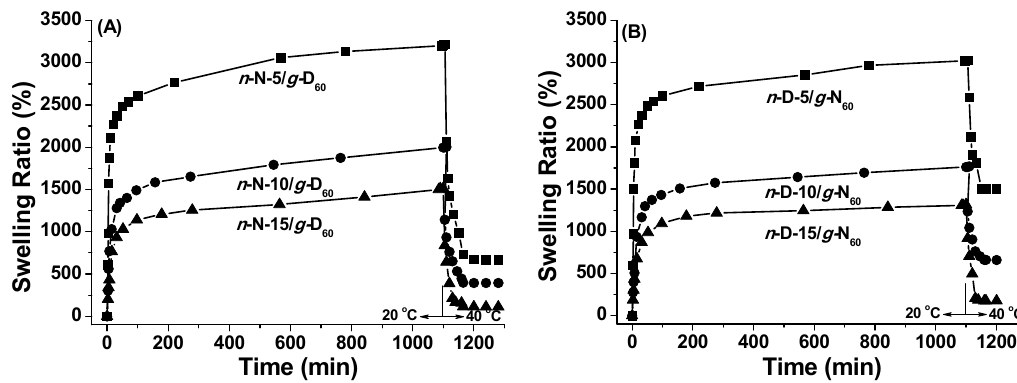
Figure 5. Swelling-deswelling kinetics of n -N/ g -D 60 ( A ) and n -D/ g -N 60 ( B ) hydrogels in deionized water at 20 and 40 °C (pH = 7.0).